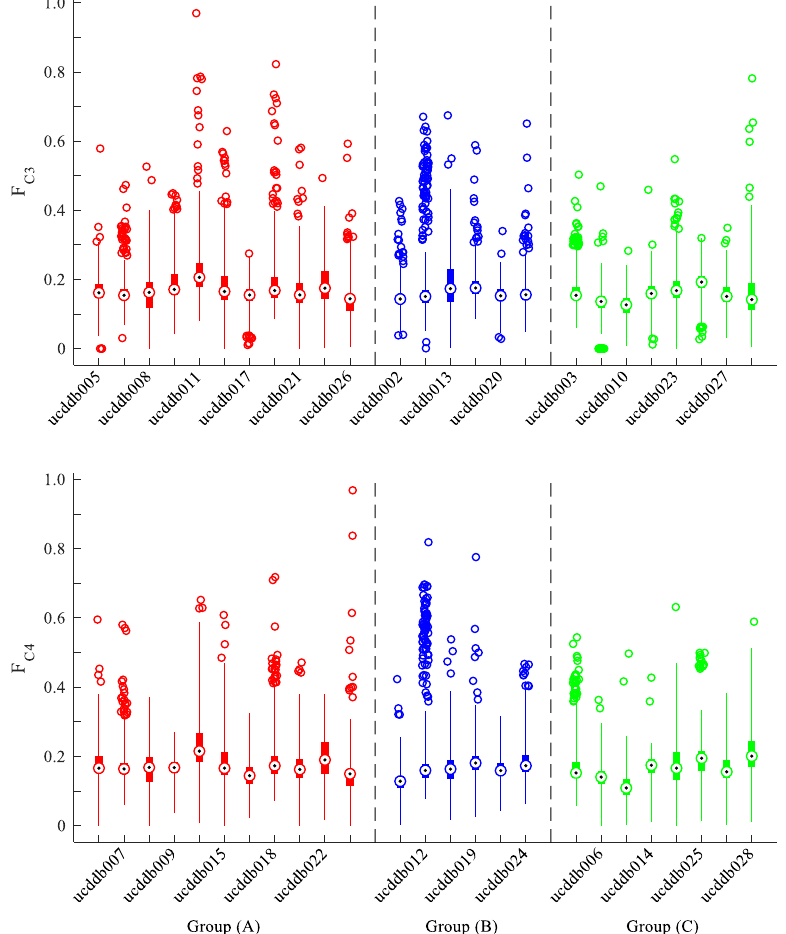
Figure 4. Box plots of the Fuzzy entropy features. The fuzzy entropy of channel C3-A2 is given in the above figure, and that of channel C4-A1 is illustrated in the below one. Red box plots represent Group A, blue represents Group B, and green represents Group C separately.